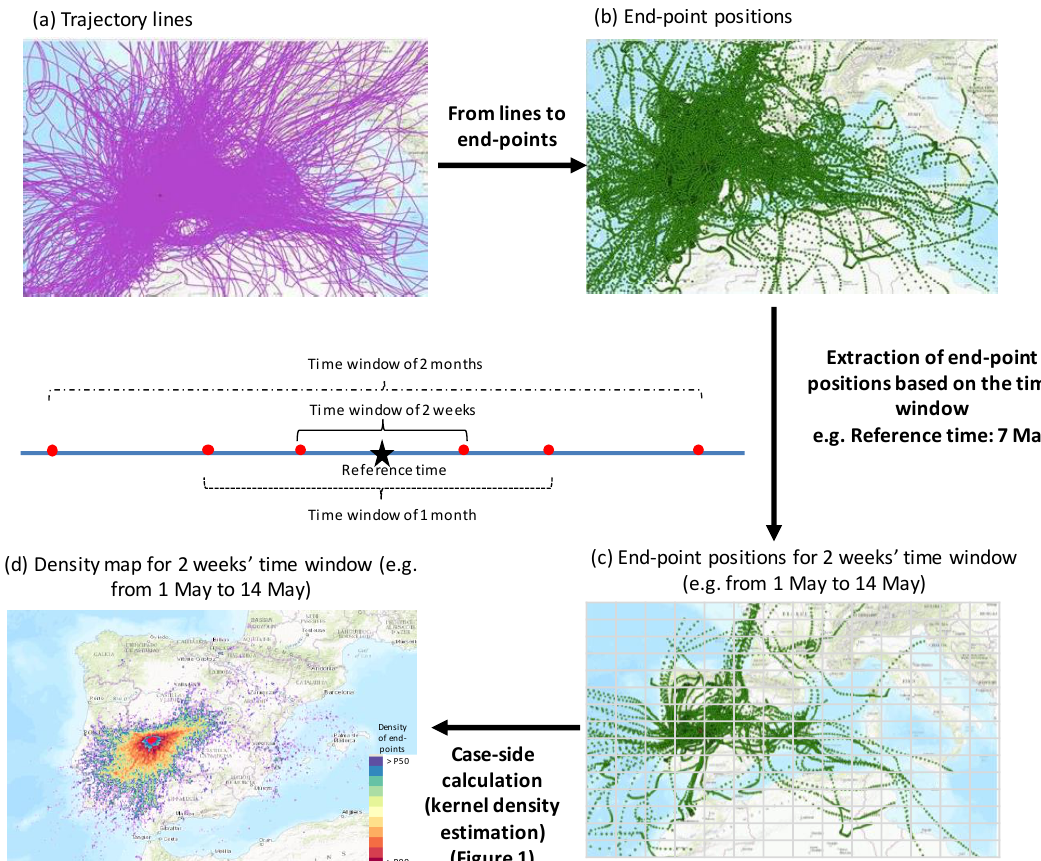
Figure 2. Steps and information used to produce the density maps: ( a ) Set of trajectory lines, ( b ) end-point positions for the 2007–2016 period, ( c ) definition of time windows and extraction of end-point positions for the defined time window (2 weeks) and ( d ) example of density map, which expresses the density of end-point positions estimated above 50%.